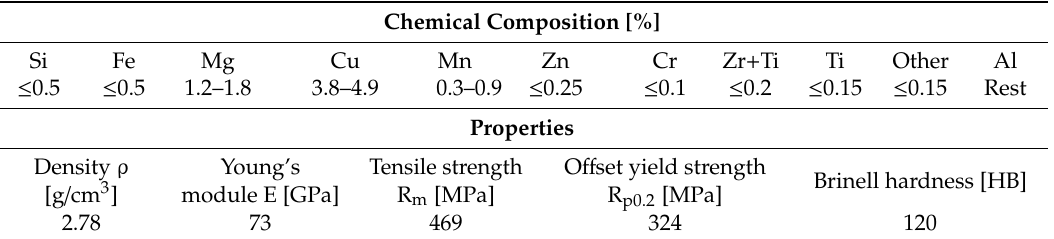
Table 1. Chemical composition and properties of EN AW-2024 T351 aluminium alloy